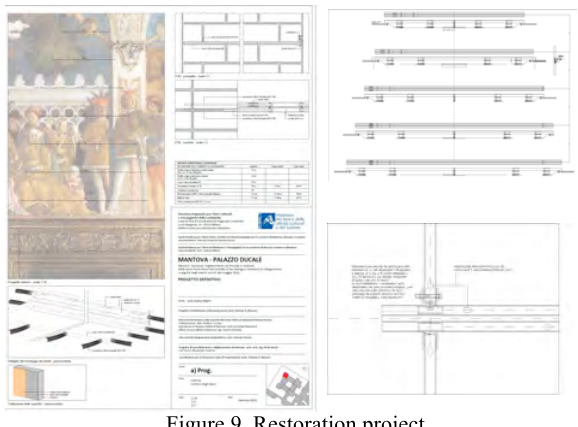
Figure 9. Restoration project